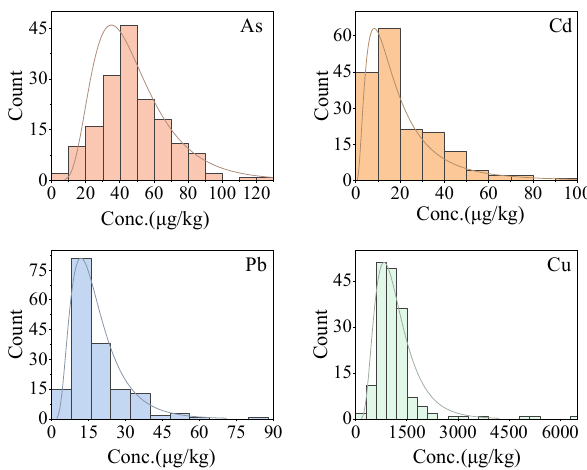
Figure 2. Histogram of As, Cd, Pb, and Cu concentrations in rice.